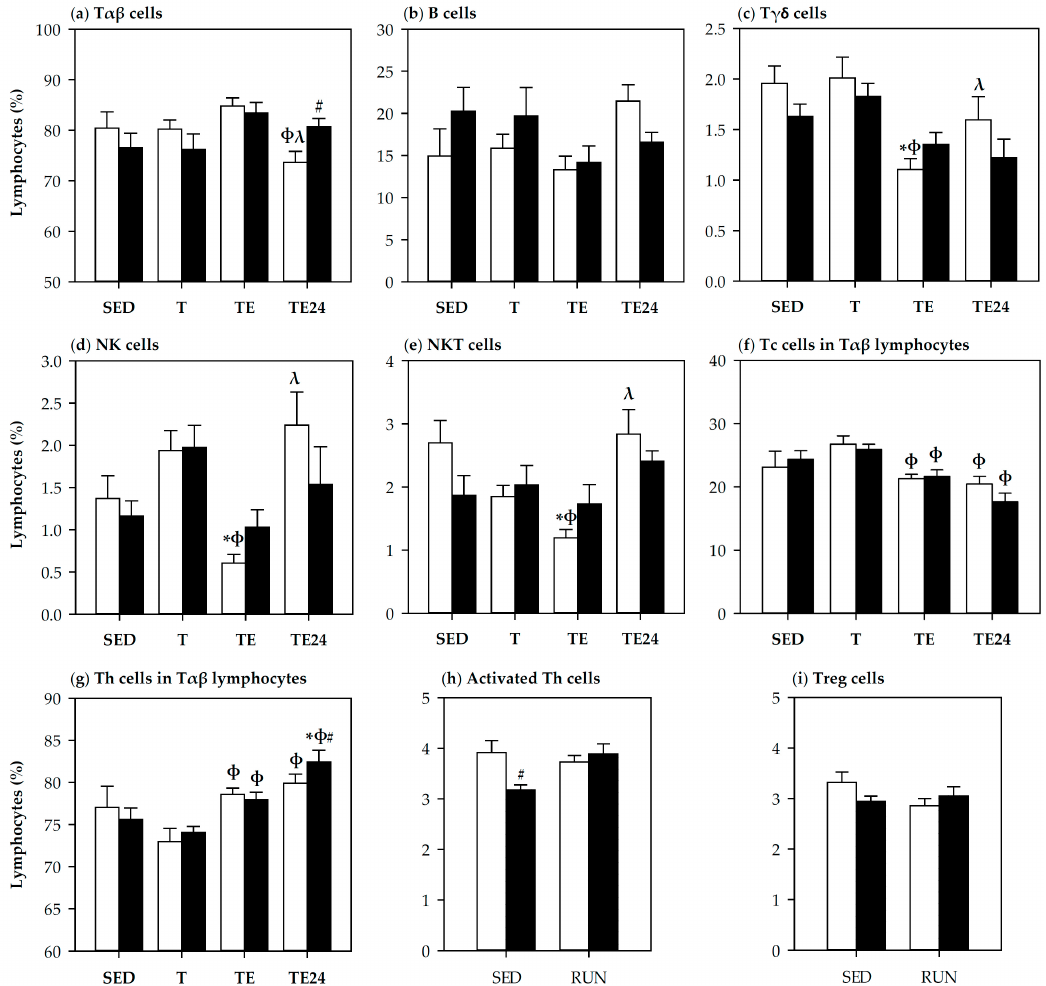
Figure 3. Percentages of blood lymphocytes: T (TCR αβ + ) ( a ), B (TCR αβ - TCR γδ -CD161b-) ( b ), T γδ (TCR γδ + ) ( c ), natural killer (NK) (CD161b + ) ( d ), natural killer T (NKT) (CD161b + TCR αβ + ) ( e ), Th (CD4 + CD161b- in TCR αβ + ) ( f ), Tc (CD8 + CD161b- in TCR αβ + ) ( g ), Tact (CD25 + Foxp3- in CD4 + TCR αβ + ) ( h ), and Treg (CD25 + Foxp3 + in CD4 + TCR αβ + ) ( i ) cells. The proportions of Treg and Tact cells were established one week before final exhausting test (therefore, all runners). The non- supplemented groups are represented by white bars and the hesperidin-supplemented groups by black bars. SED = sedentary groups; T = trained groups; TE = T groups with an additional exhaustion test; TE24 = TE groups 24 h after the exhaustion test. Data are expressed as mean ± SEM ( n = 8 for a – g , n = 8-15 for h , i ). Statistical difference (Mann–Whitney U test): * p < 0.05 vs. SED group; φ p < 0.05 vs. T group; λ p < 0.05 vs. TE group; # significant differences between non-supplemented and the counterpart hesperidin-supplemented group ( p < 0.05).